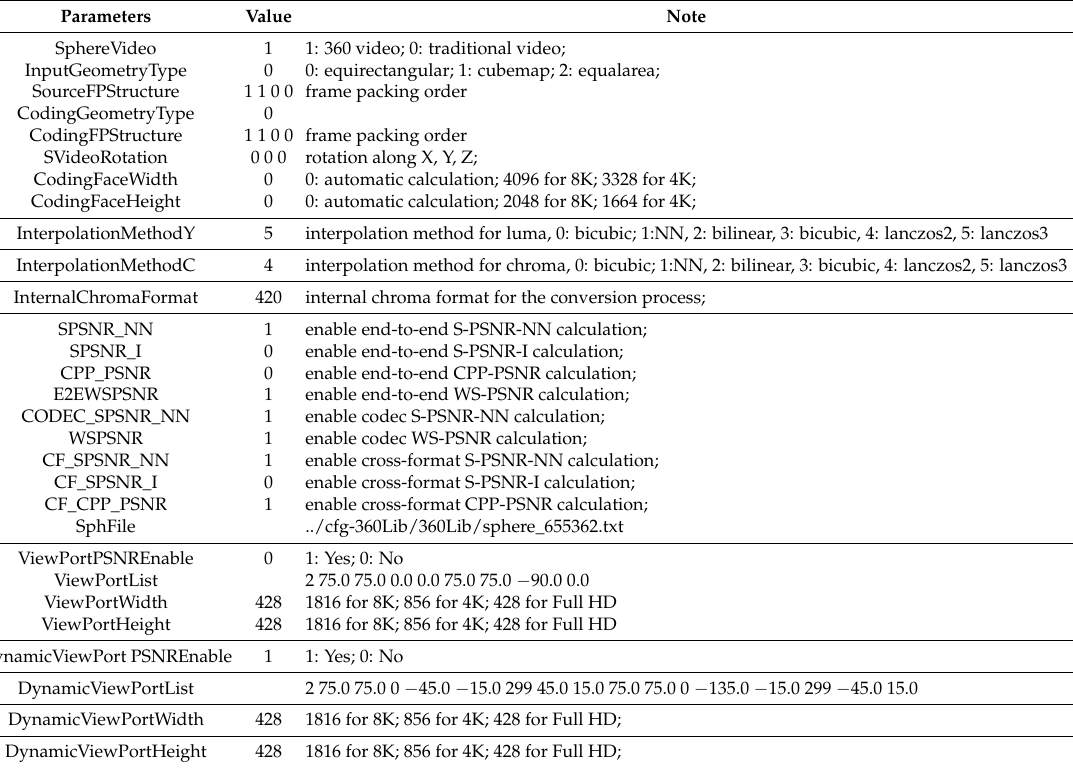
Table A1. Equirectangular projection for 360 video.